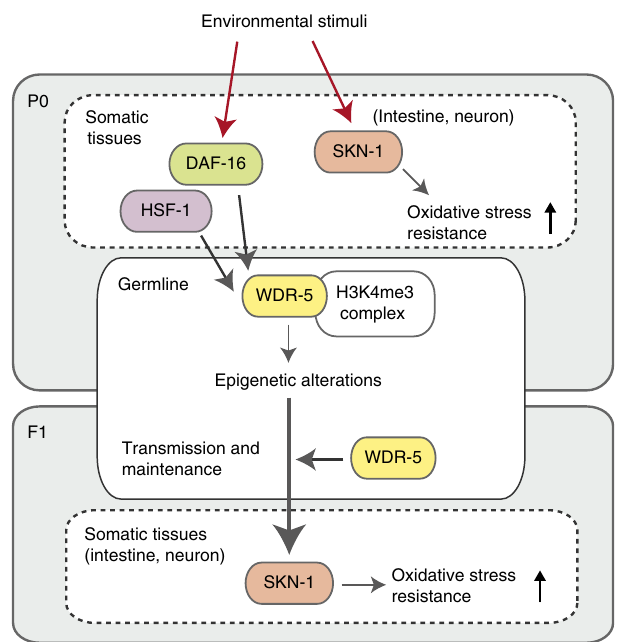
Figure 7 | Overview model of transgenerational inheritance of epigenetic memory in response to environmental stimuli. In the P0 generation, somatic DAF-16 and HSF-1 communicate with the H3K4me3 complex in the germline so as to regulate and maintain epigenetic alterations associated with inheritable acquired traits, and the H3K4me3 complex in the filial germline then transfers hormetic information to SKN-1 of the somatic